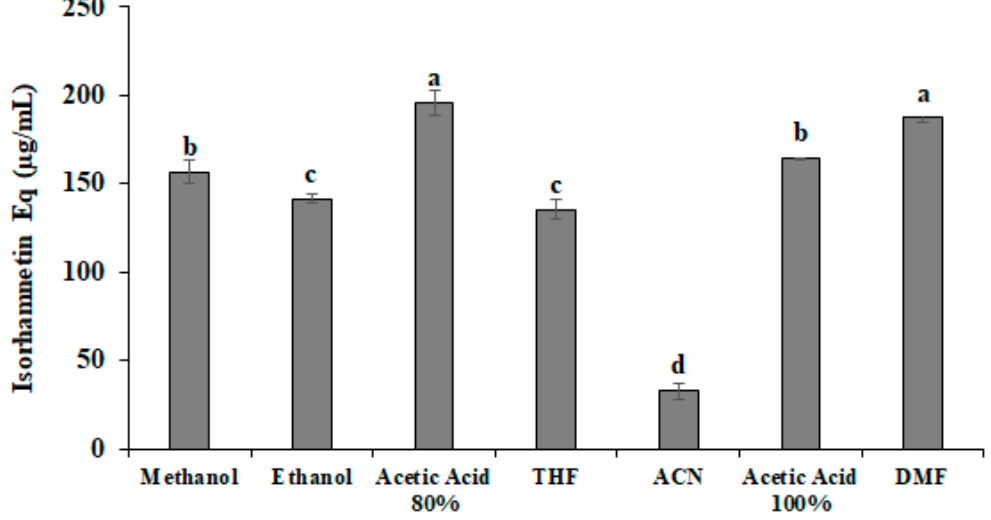
Figure 2. Isorhamnetin equivalents (IsoEq) in a 12% w / v of Opuntia ficus-indica (OFI) extract solution using different solvents. Data are shown as mean ± SD values. (a,b,c,d) Values with a different letter(s) are statistically different (HSD Tukey p < 0.05).